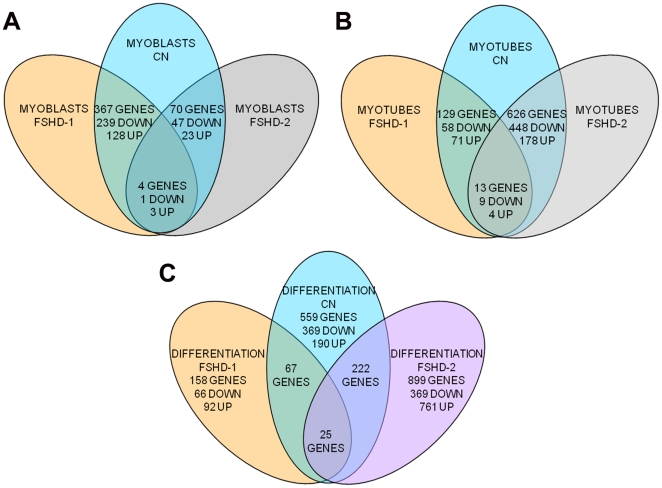
Venn diagrams showing overlapping and non-overlapping counts of genes differentially expressed.A): FSHD-1 and FSHD-2 myoblasts, in respect to controls; 367 genes were up- (128) or down- (239) regulated in FSHD-1 myoblasts and 70 genes were up- (23) or down- (47) regulated in FSHD-2 myoblasts. Four (3 up and 1 down) genes were deregulated in both cell lines. B): FSHD-1 and FSHD-2 myotubes, in respect to controls; 129 genes were up- (71) or down- (58) regulated in FSHD-1 myotubes and 626 genes were up- (178) or down- (448) regulated in FSHD-2 myotubes. Thirteen (4 up and 9 down) genes were deregulated in both cell lines. C): FSHD-1 and FSHD-2 differentiation processes, in respect to the differentiation of control cells; 559 genes were modulated in the differentiation of CN cells, 158 in the differentiation of FSHD-1 and 899 of FSHD-2, cells. FSHD-1 and CN differentiation processes shared 67 entries, whereas FSHD-2 and CN differentiation processes shared 222 entries. FSHD-1 and FSHD-2 differentiation processes shared 25 deregulated genes. FC>2 and p-value <0.01 and <0.001 for FSHD-1 and FSHD-2, respectively.